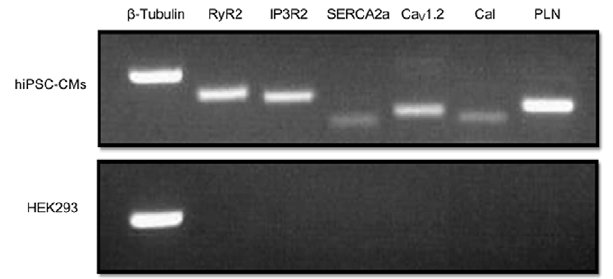
Figure 1. Semi-quantitative RT-PCR analysis for cardiac- specific Ca 2 + -handling proteins in hiPSC-CMs. Gene expression pattern of proteins involved in Ca 2 + -handling in hiPSC-CMs (upper panel) and control HEK293 cells. The lower panel displays genes expression in control HEK293 cells. b -tubulin was used as a normalizing house-keeping gene. Abbreviations: RyR2, ryanodine receptor; IP3R2, inositol 1,4,5-triphosphate receptor; SERCA2a, SR Ca ATPase; Ca V 1.2, L- type Ca 2 + channels; Cal, calsequestrin, and PLN, phospholamban.